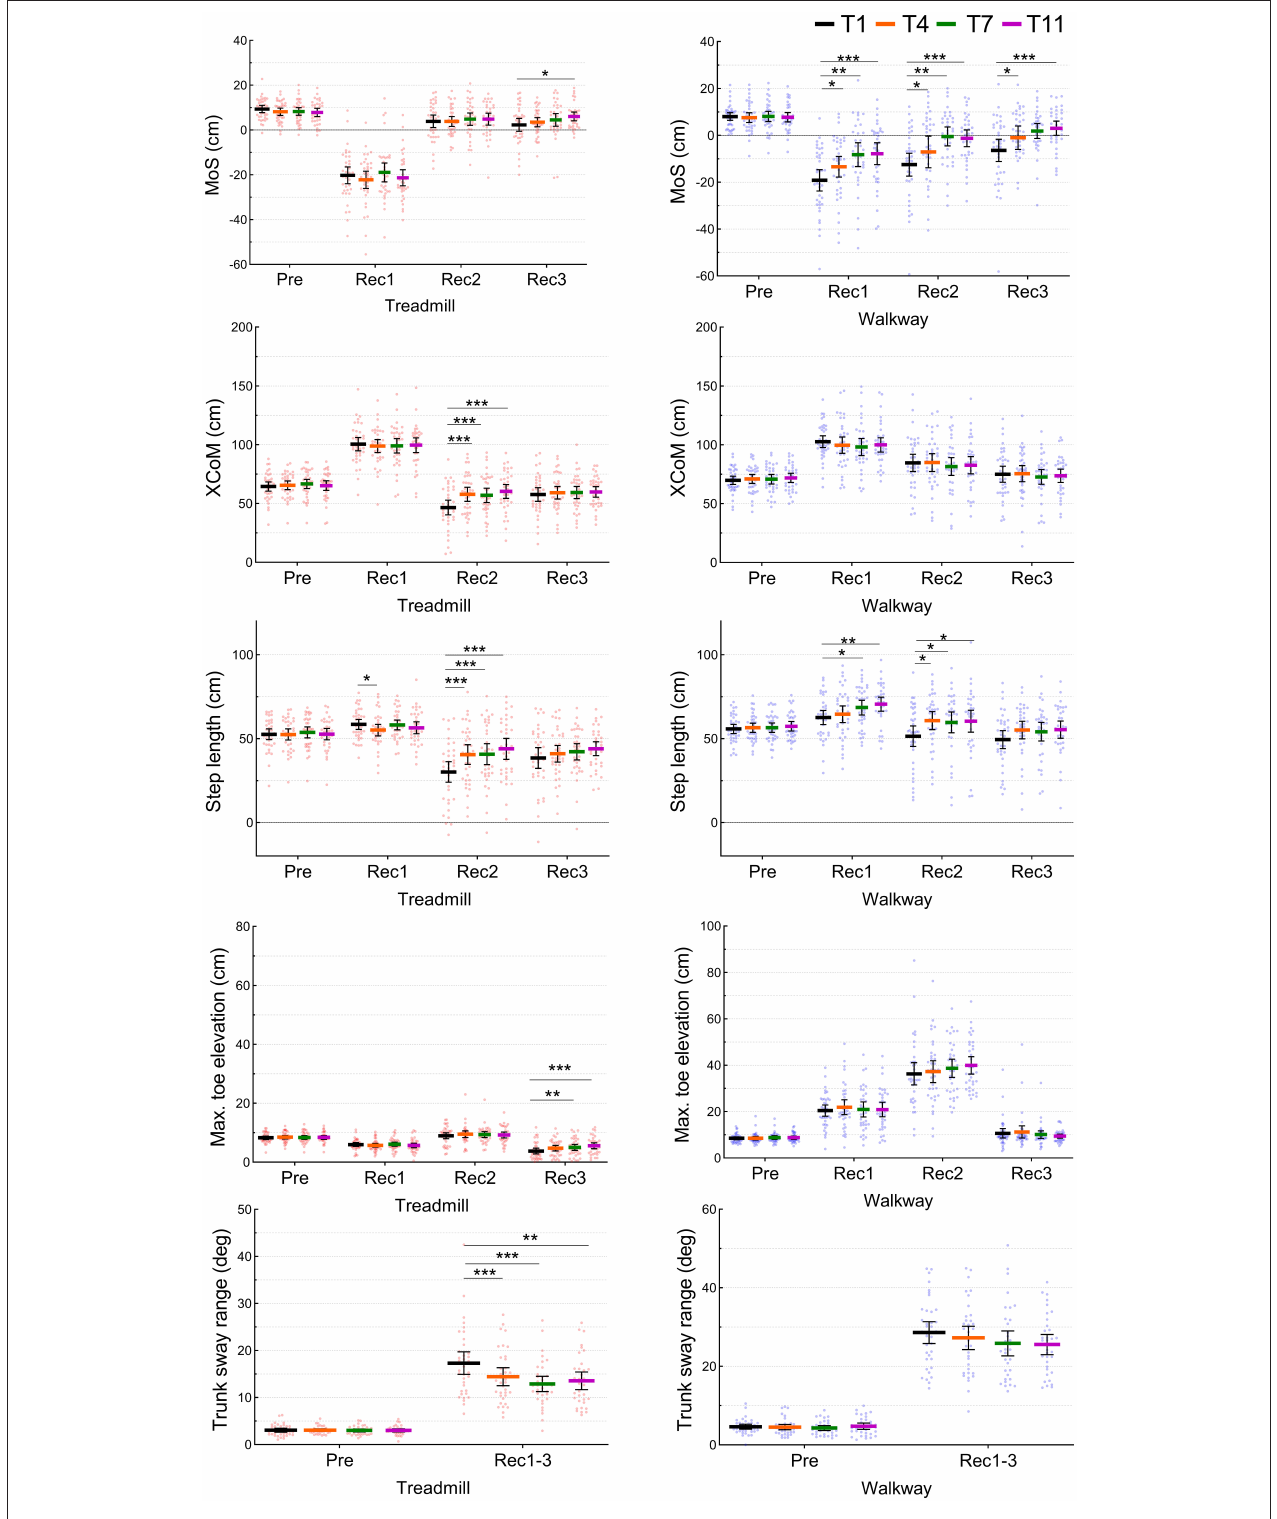
FIGURE 3 | Kinematic parameters at one previous (Pre) and three recovery (Rec1, Rec2, and Rec3) steps during four trip trials (T1, T4, T7, and T11) on the treadmill and overground walkway ( n = 38). The mid lines and error bars represent means and 95% confidence intervals. * P < 0.05, ** P < 0.01, *** P < 0.001.